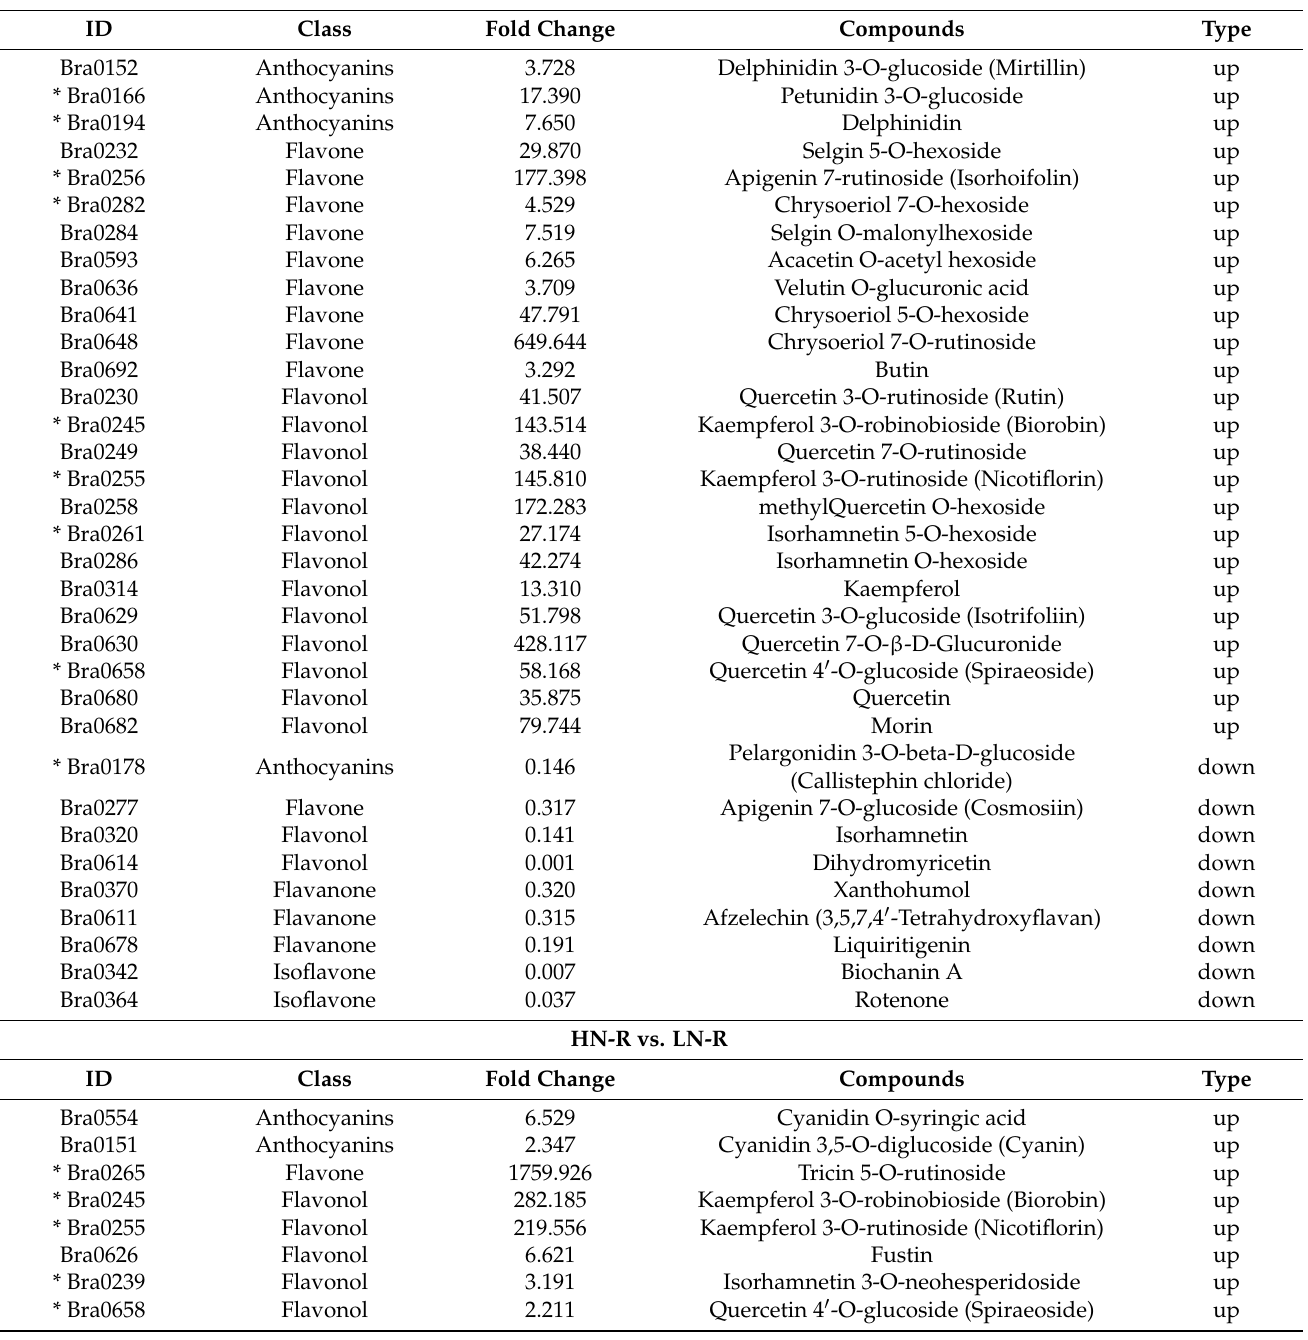
Table 1. Fold change of flavone and flavonoid metabolites detected in the HN leaf when compared to the LN leaf and, HN root compared to the LN root, respectively. Asterisk marks indicate that the metabolite was detected both in the leaf and